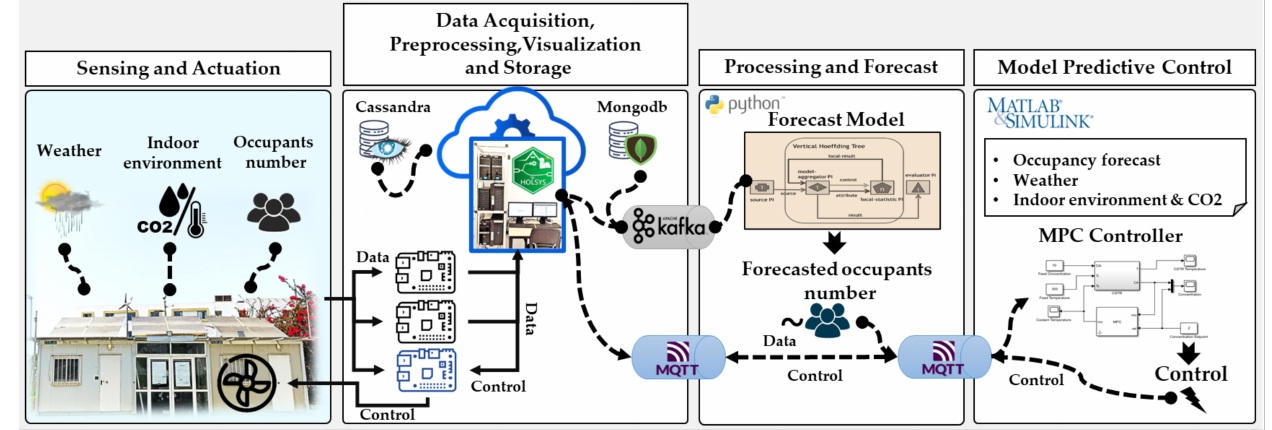
Figure 10. The experimental setup architecture of HIL implementation of the MPC for EEBLab ventilation system control enabled by the HOLSYS IoT